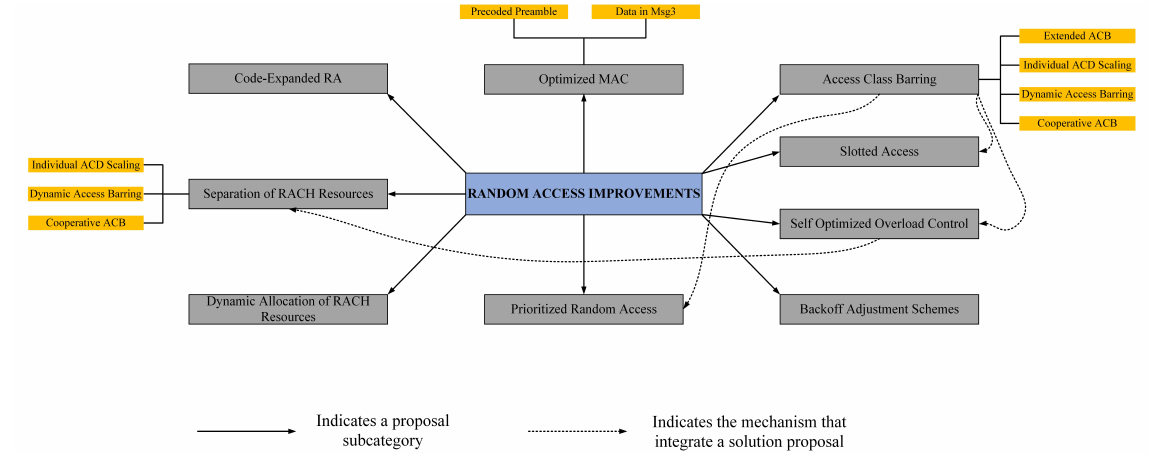
Figure 2. Techniques to improve random access